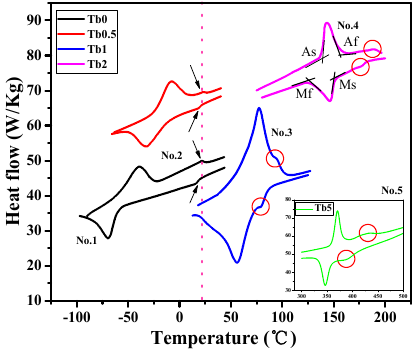
Figure 4. DSC curves of the Ni 48 Mn 39 Sn 13 − x Tb x alloys.